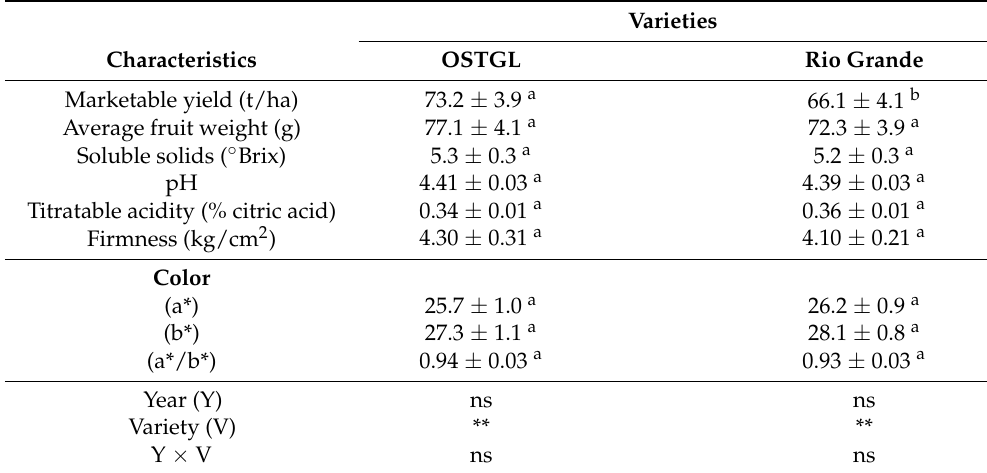
Table 2. Yield and physicochemical parameters of the different tomato varieties grown organically.